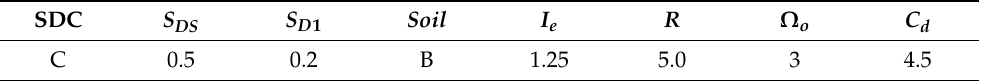
Table 2. Geotechnical, seismic and structural parameters considered for the design of